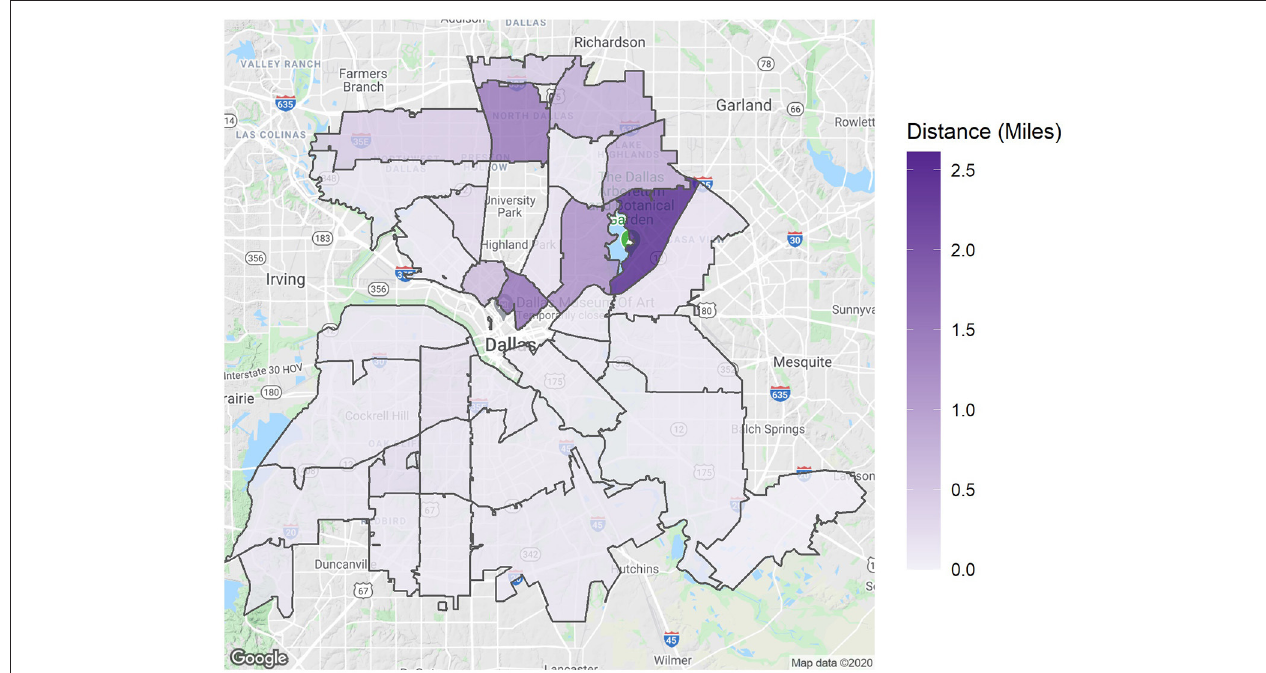
FIGURE 5 | Median distance traveled by RTO strays per intake ZIP code.